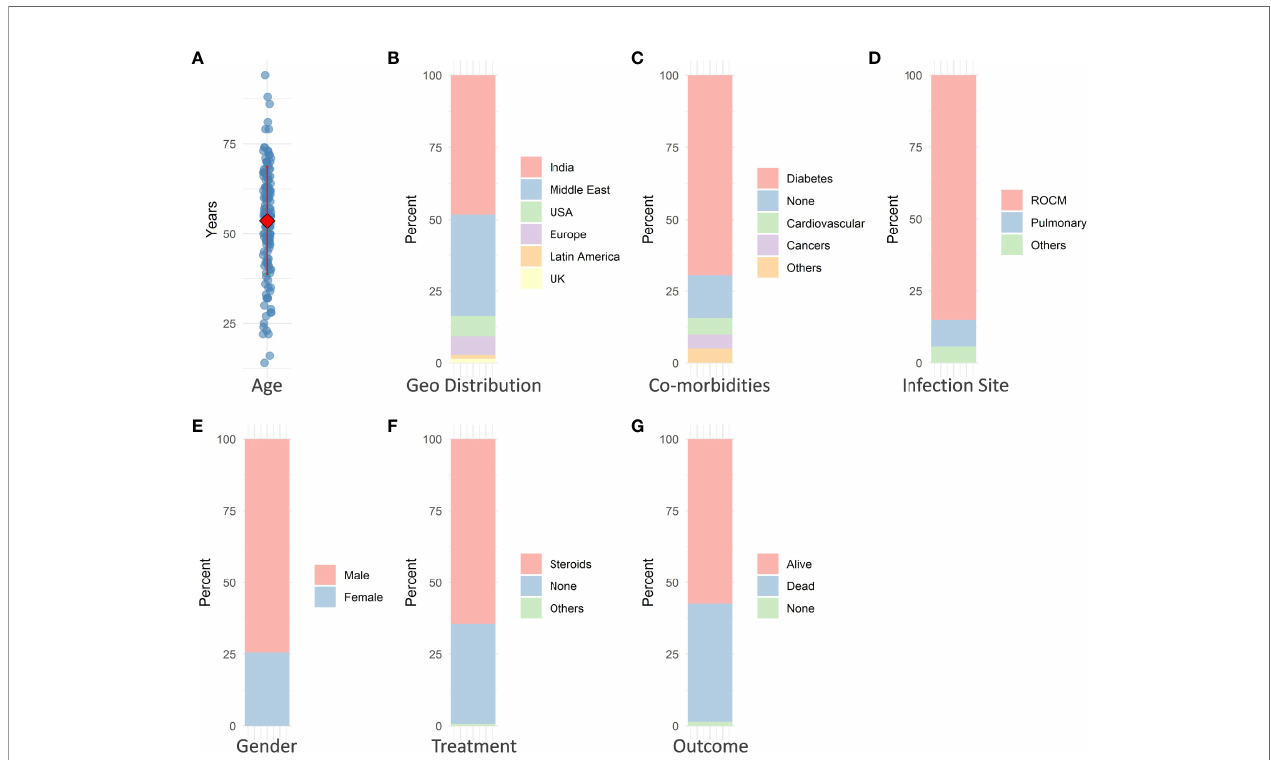
FIGURE 1 | Some of the major observable factors in COVID-19-associated mucormycosis. (A) Mean age of patients is ~54 years. (B) Most of the cases were reported from India (>48%). (C) Majority of the patients were diabetic (~70%). (D) Rhino-orbito-cerebral mucormycosis (ROCM) predominated in occurrence (~85%). (E) Men (~75% of total patients) were infected more than women. (F) Approximately 65% of patients underwent steroid therapy. (G) More than 41% of mucormycosis infections resulted in patient